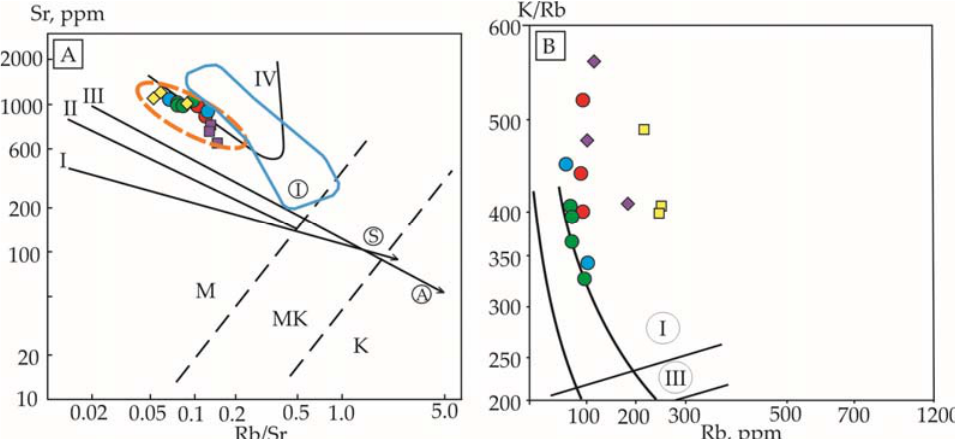
Figure 7. ( A ) Sr ‐ Rb/Sr ratio in igneous rocks from Medvedev and Taezhniy massifs. Composition Figure 7. ( A ) Sr-Rb/Sr ratio in igneous rocks from Medvedev and Taezhniy massifs. Composition fields of magma ‐ forming sources [48]: M—mantle, MK—mantle ‐ crustal, K—crustal; 1—typical fields of magma-forming sources [48]: M—mantle, MK—mantle-crustal, K—crustal; 1—typical compositions of M, I, S and A ‐ type granites; 2—trends of differentiation of type and volcanic series: compositions of M, I, S and A-type granites; 2—trends of differentiation of type and volcanic series: I—tholetic of island arcs (OD), II—calc ‐ alkaline (CA), III—calc ‐ alkaline of active continental mar ‐ I—tholetic of island arcs (OD), II—calc-alkaline (CA), III—calc-alkaline of active continental margins gins (ACM); IV—rift zones of the continents; ( B ) K/Rb ‐ Rb ratio in igneous rocks: diagram fields (ACM); IV—rift zones of the continents; ( B ) K/Rb-Rb ratio in igneous rocks: diagram fields according according to [50], formations: I—mantle, III—mantle ‐ crustal. The plots were performed according to [50], formations: I—mantle, III—mantle-crustal. The plots were performed according to the ICP to the ICP MS data. The other symbols and fields are as in Figure 4 and Figure 6, respectively. MS data. The other symbols and fields are as in Figures 4 and 6,